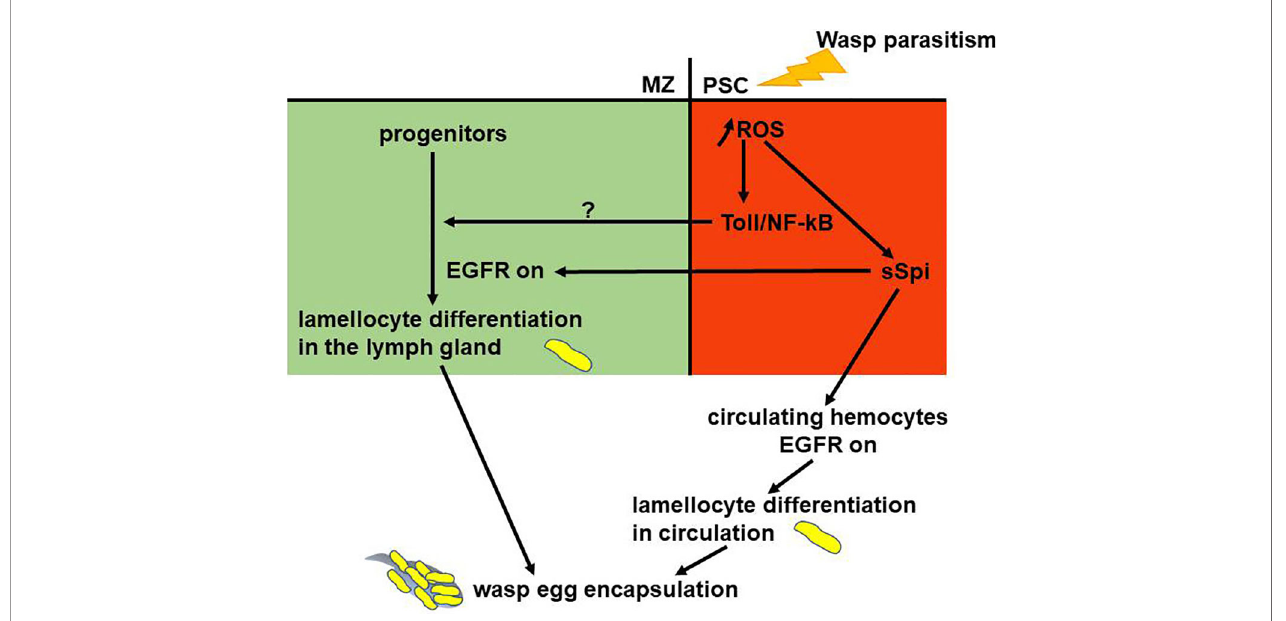
FIGURE 4 | Gene regulatory network controlling larval emergency hematopoiesis. The PSC (red) plays an essential role in mounting the cellular immune response. In response to wasp parasitism, increased Reactive Oxygen Species (ROS) levels in the PSC cause lamellocyte differentiation from lymph gland progenitors (green) and circulating hemocytes. ROS in PSC cells activate Toll/NF-kB and Spitz secretion (sSpi). sSpi, the EGFR ligand, induces lamellocyte fate. Toll/NF-kB activation in the PSC regulates non cell-autonomously lamellocyte differentiation in the lymph gland. EGFR and Toll/NF-kB activation are required to regulate lymph gland stress